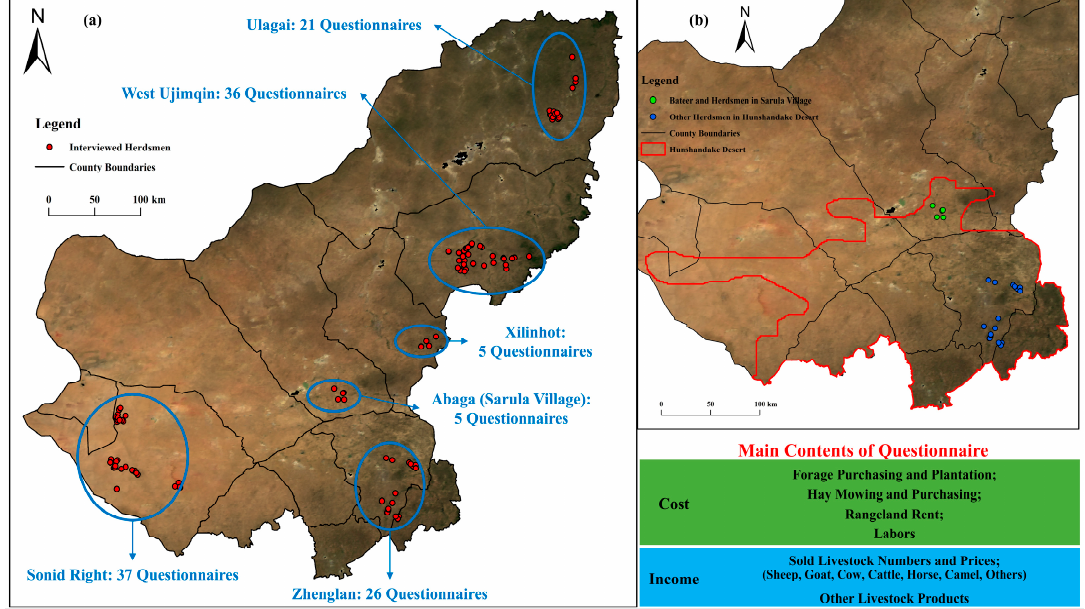
Figure 2. The locations of interviewed herdsmen in (a) Xilin Gol and (b) Hunshandake desert.